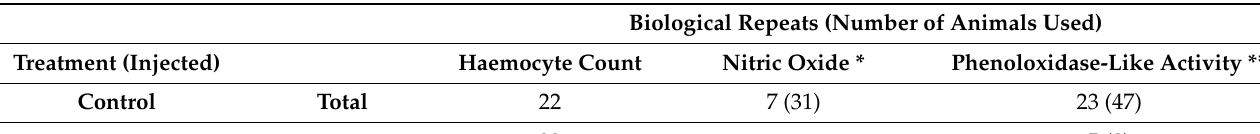
Table A2. Details regarding the number of animals used in the injection experiment and the stages of the investigation. *, pooled from 4–5 animals; **, pooled from 1–3